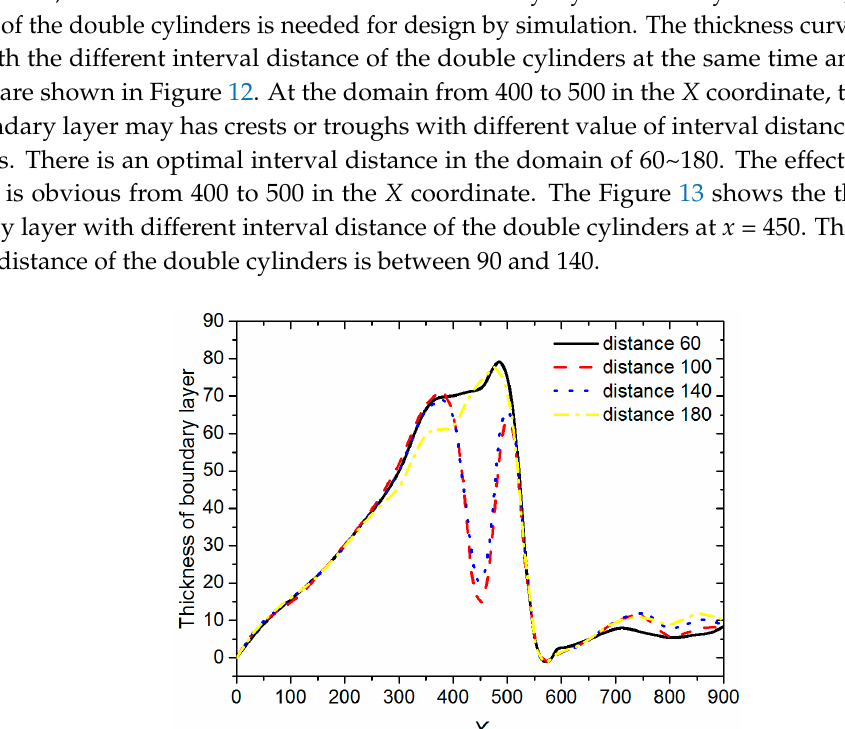
Figure 12. The thickness of the boundary layer with different interval distance of the double cylinders (interval distance of the double cylinders is 60, 100, 140, 180).